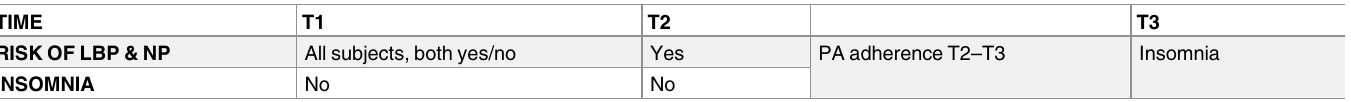
Table 1. Model 1: Examining the effect of PA adherence on subjects with LBP/NP risk profiles at T2 on the risk of developing insomnia at T3, regardless of previous pain at T1 (n = 436). TIME T1 T2 T3 RISK OF LBP & NP